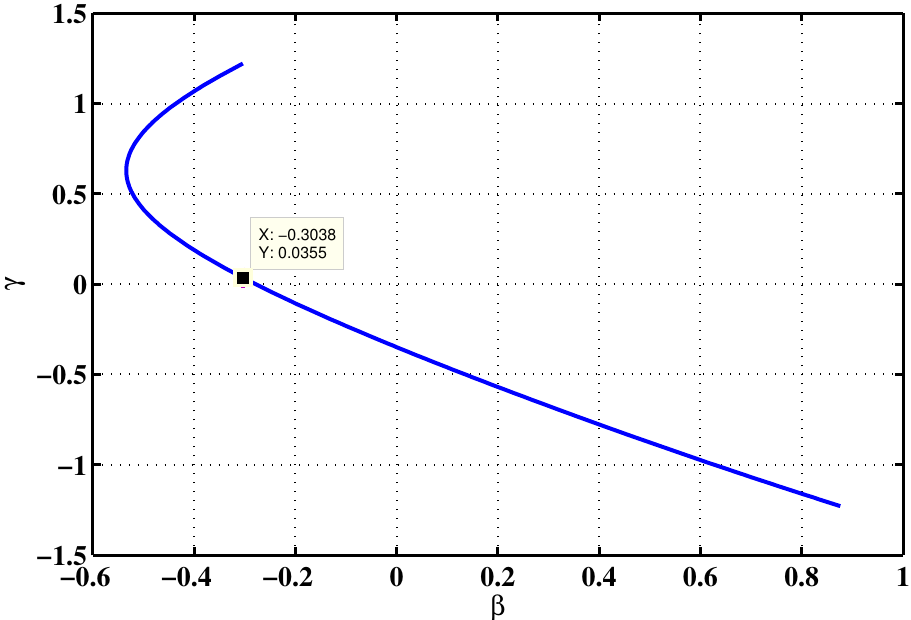
Figure 20. Locus of the solutions of Equation (8) in the ( β , γ ) plane.